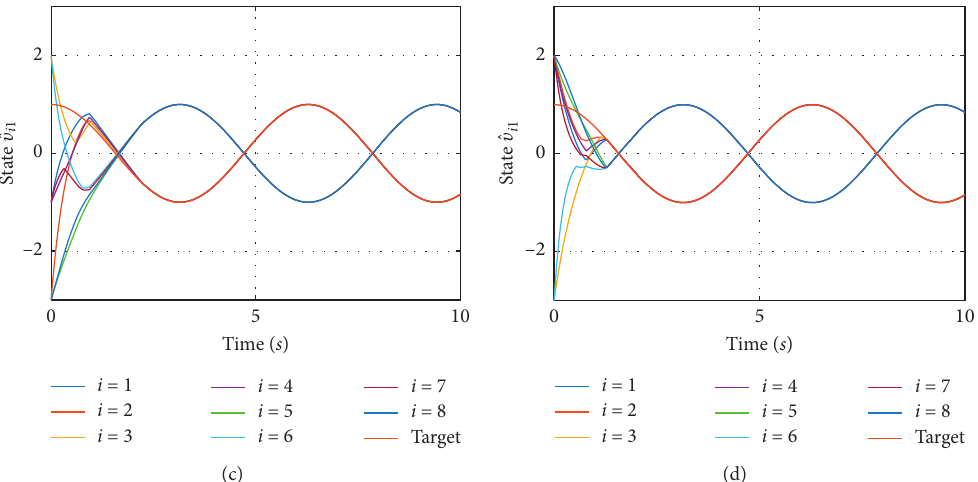
􏽢 v i for links 1